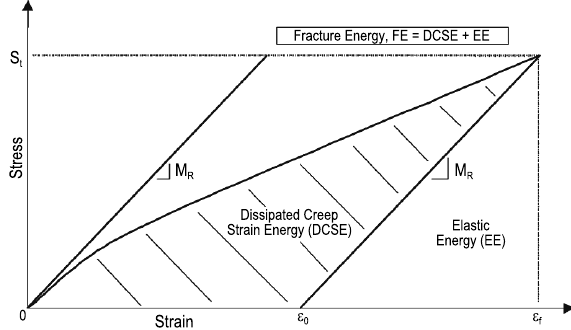
Fig. 1. Schematic of energy based parameters obtaining from a stress-strain curve after (Grant 2001; Zhang et al. 2001)